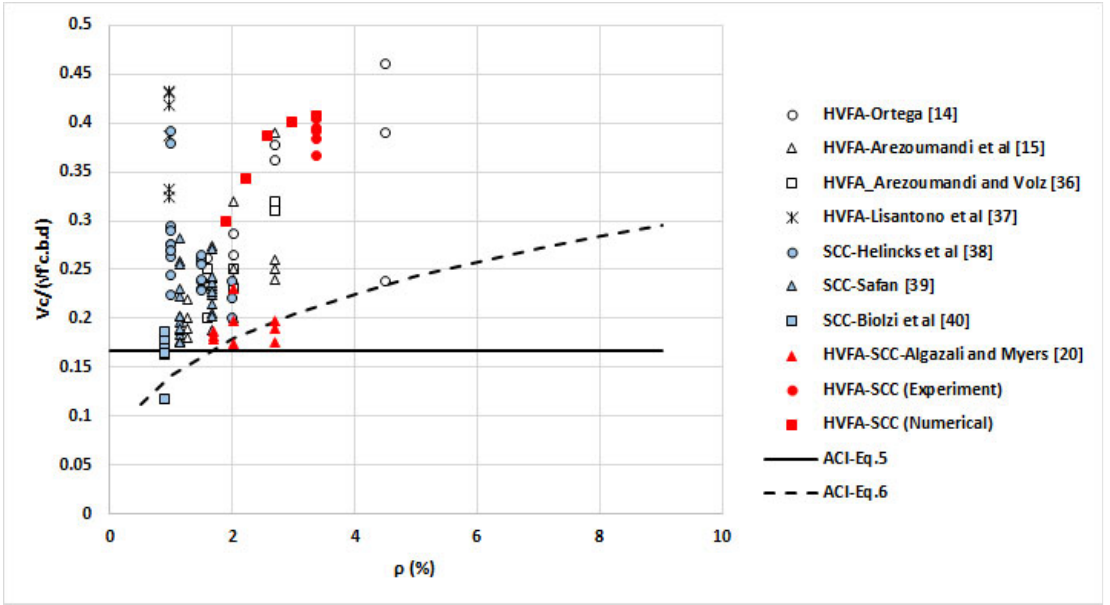
Buildings 2021 , 11 , x 19 of 21 Figure 19. Normalized shear strength of non ‐ conventional concrete vs. beam effective depth ratio. Figure 19. Normalized shear strength of non-conventional concrete vs. beam effective depth ratio.